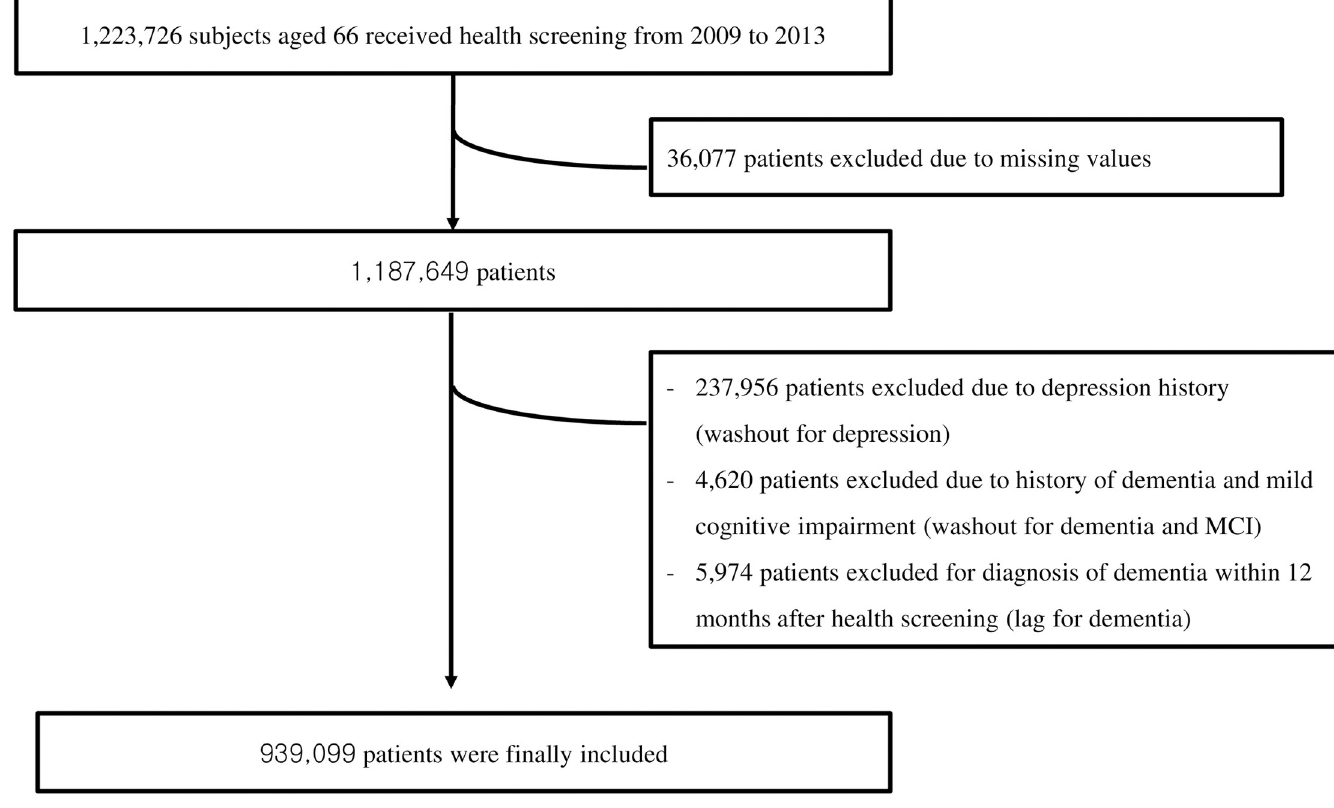
Fig 2. Flow chart depicting creation of study